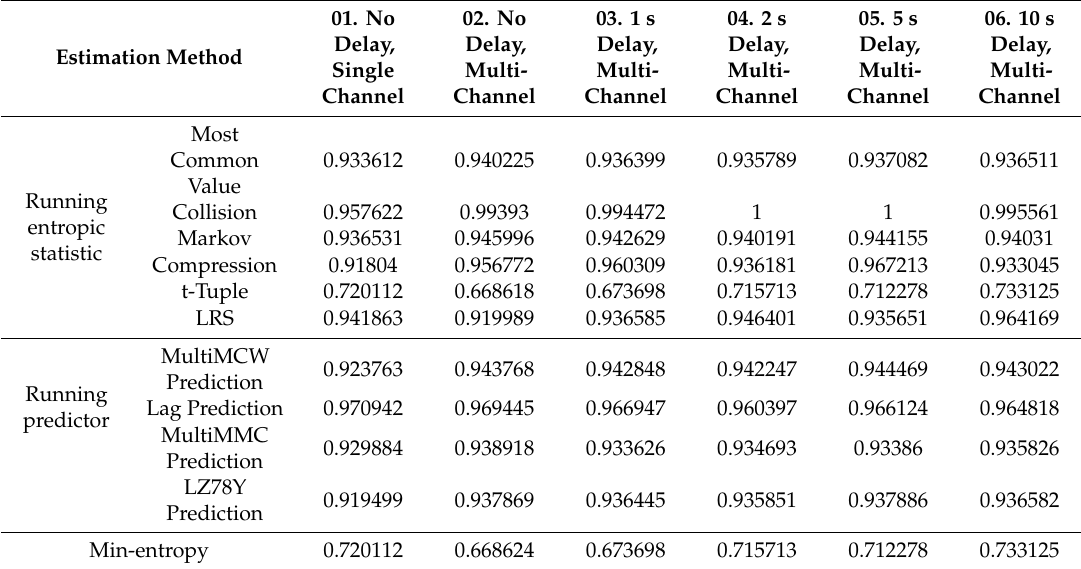
Table 2. Entropy comparison results of the m4a file format generated from radio signals collected under all conditions.